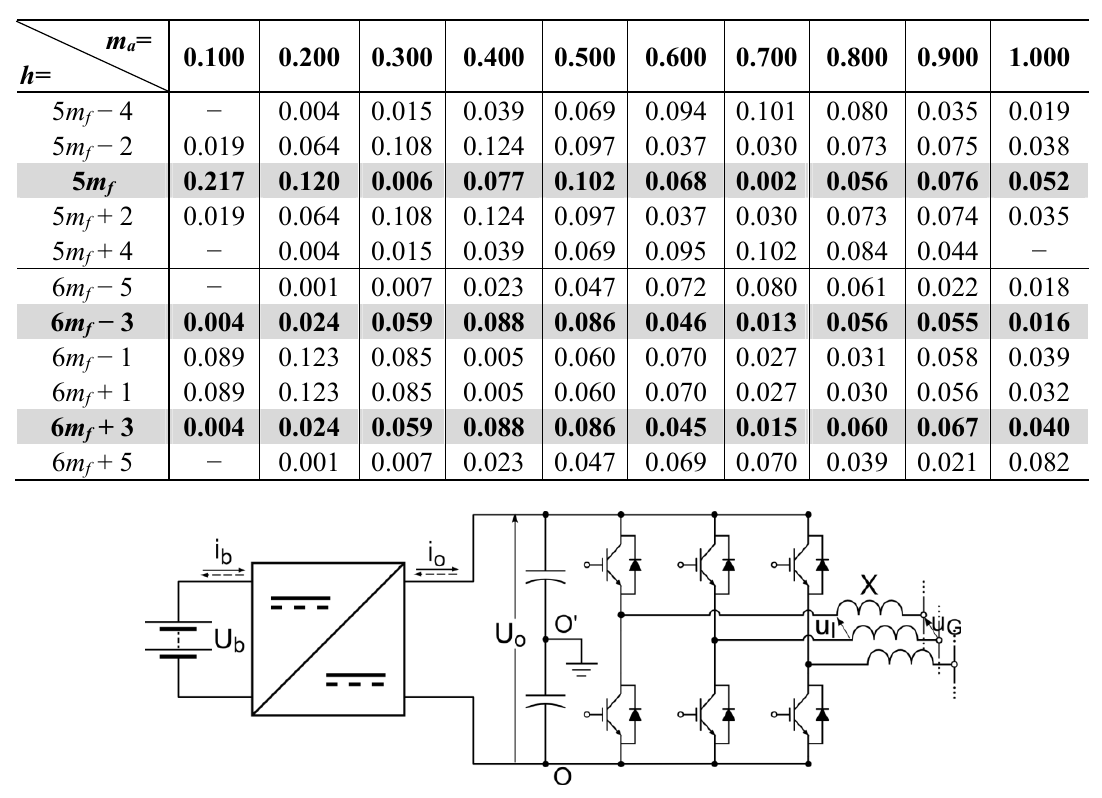
Figure 1. Basic two-stage converter configuration.